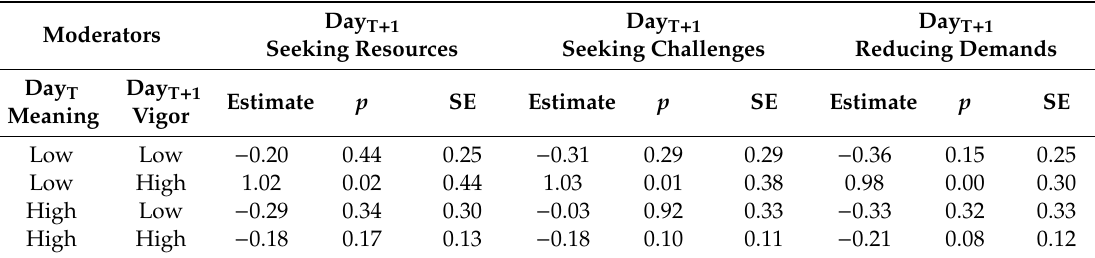
Table 3. Conditional e ff ect of leader day T empowering behaviors on employee day T + 1 job crafting at values of the moderators.